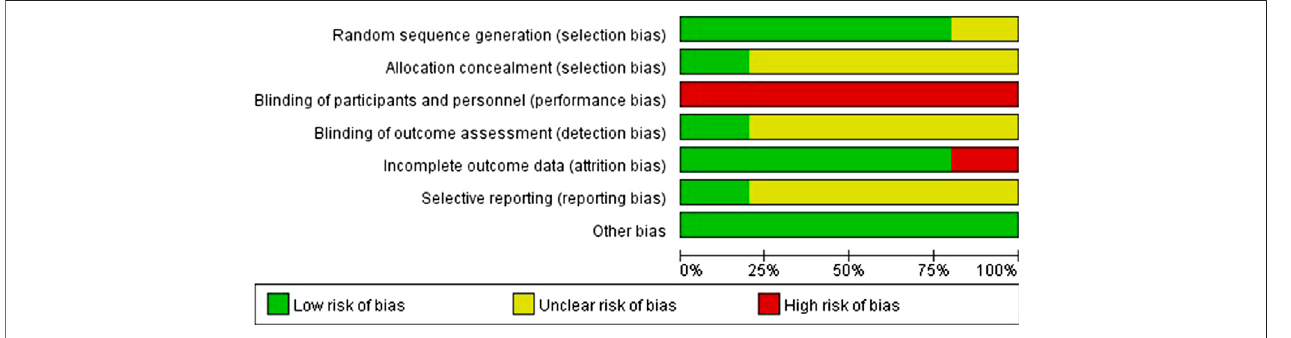
FIGURE 3 | Risk of bias graph of included 10